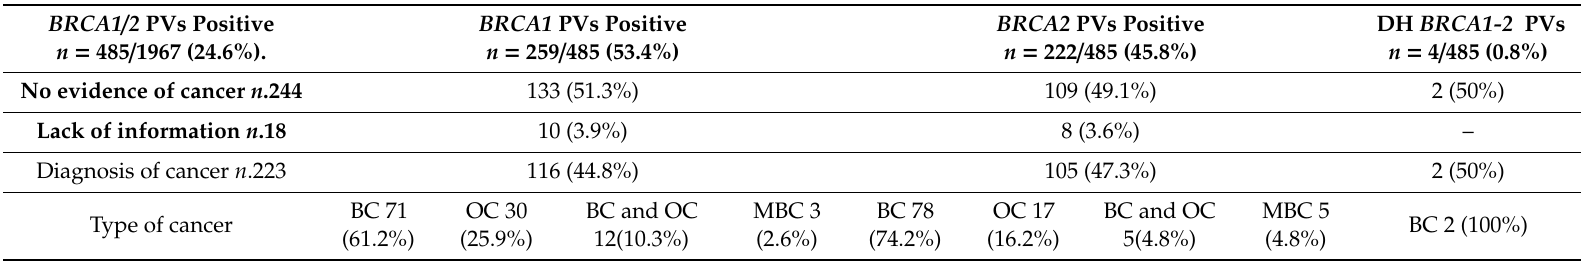
Table 2. Total number of tested individuals (probands and family members), number of individuals carrier of germline BRCA1 / 2 PVs and type of tumors. BRCA1 / 2 PVs Positive BRCA1 PVs Positive BRCA2 PVs Positive DH BRCA1-2 PVs n = 485 / 1967 (24.6%). n = 259 / 485 (53.4%) n = 222 / 485 (45.8%) n = 4 / 485 (0.8%) No evidence of cancer n .244 133 (51.3%) 109 (49.1%) 2 (50%) Lack of information n .18 10 (3.9%) 8 (3.6%) – Diagnosis of cancer n .223 116 (44.8%) 105 (47.3%) 2 (50%) BC 71 OC 30 BC and OC MBC 3 BC and Type of cancer (61.2%) (25.9%) 12(10.3%) (16.2%)